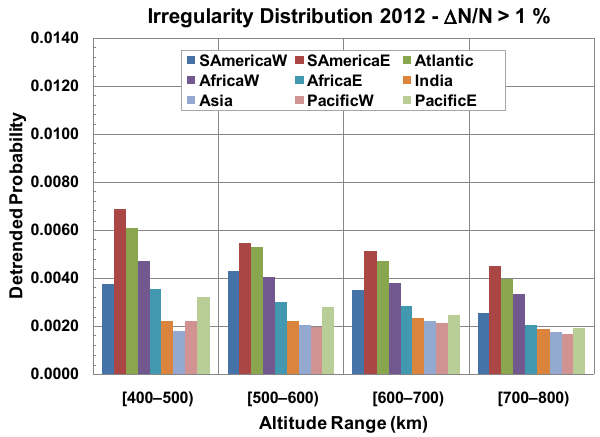
Figure 12. Detrended probability distributions of ∆ N i / N i > 1 % as functions of altitude ranges and longitude sectors for 2012